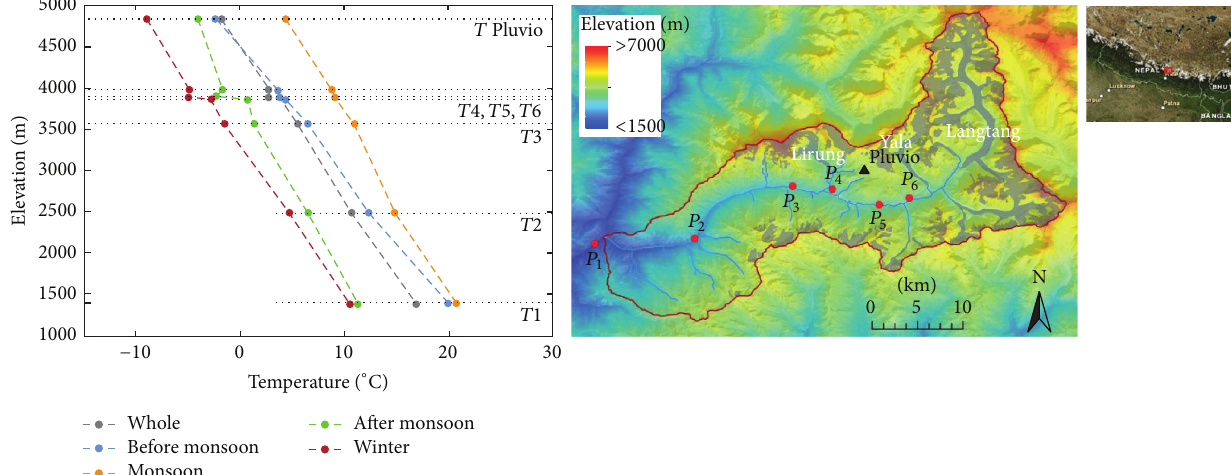
Figure 5: Mean temperature measured at the sites in the right figure plotted against elevation for the entire period (8 May 2012 to 1 May 2013), before monsoon, monsoon, after monsoon, and winter. Modified from Immerzeel et al.